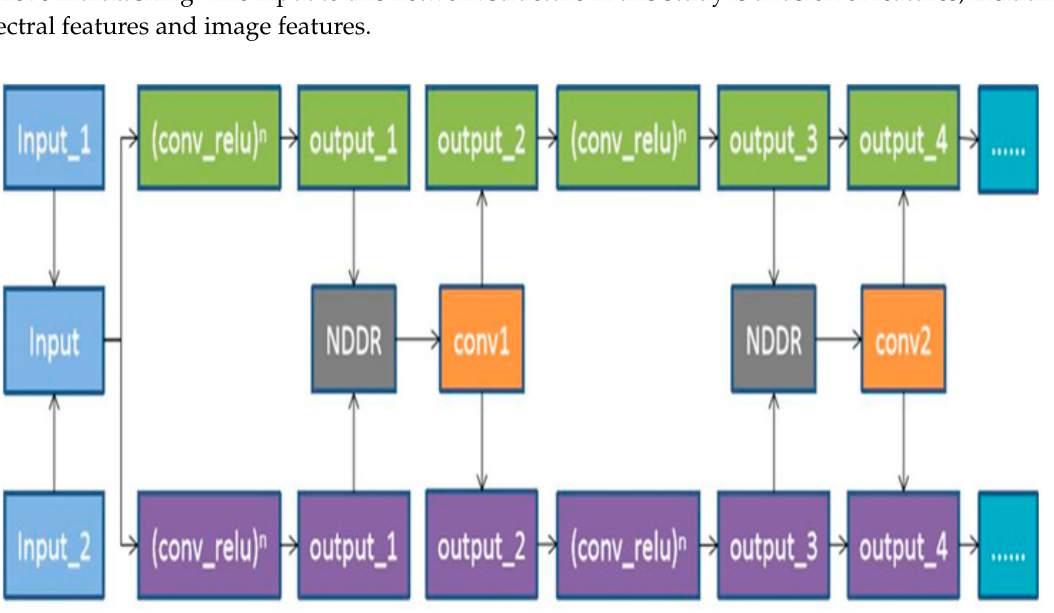
Figure 5. Neural discriminative dimensionality reduction (NDDR)-CNN architecture for black spot detection.